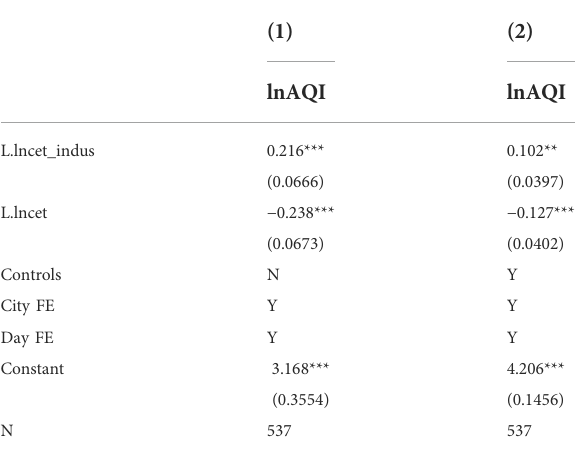
TABLE 7 Air quality and carbon emissions trading. TABLE 6 Industrialization level and carbon